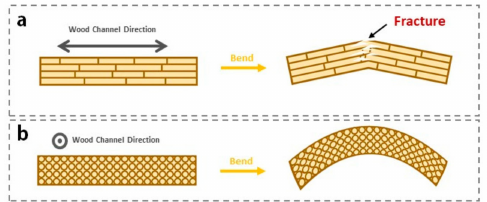
Figure 2. Graphical illustration showing two di ff erent direction of wood. ( a ) Bending deformation along wood channels direction. ( b ) Bending deformation along the direction perpendicular to the wood